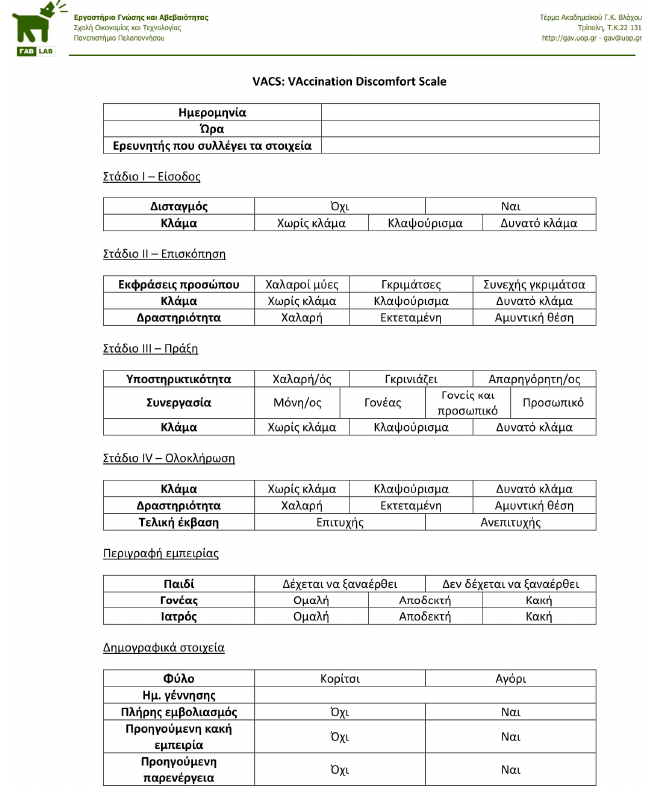
Figure A1. The form used to collect the data.